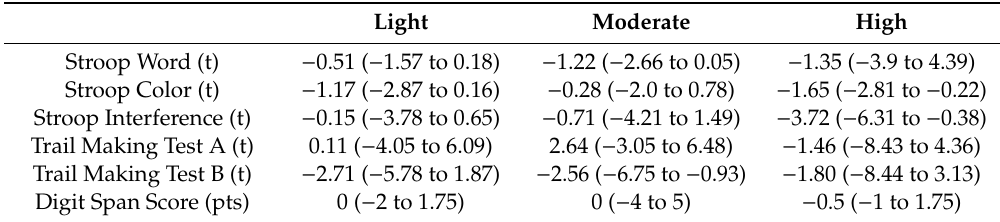
Table 3. Absolute pre-post di ff erences in cognitive measures as a function of exercise.